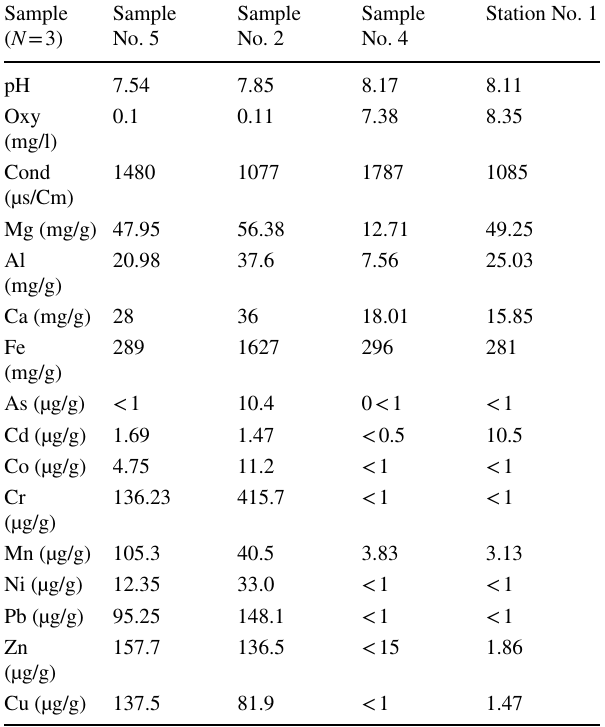
measurements « of the physicochemical parameters (average of three replicas) of Sebou and Fez Rivers Sample ( N =